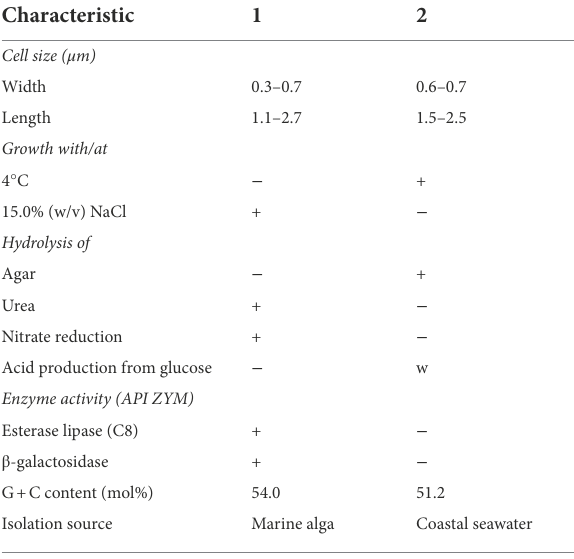
TABLE 1 Differential characteristics of strain HB14 T and G. chinensis CGMCC 1.7008 T . Characteristic